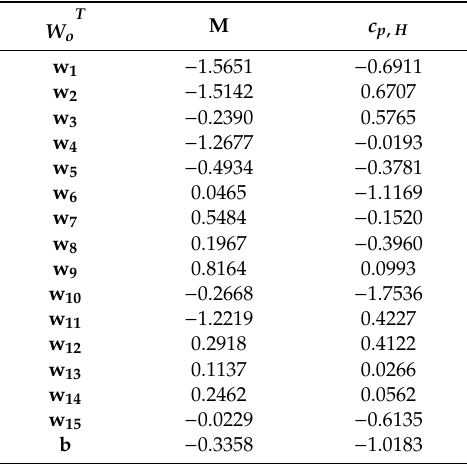
Table A2. Output synaptic weights of Gd